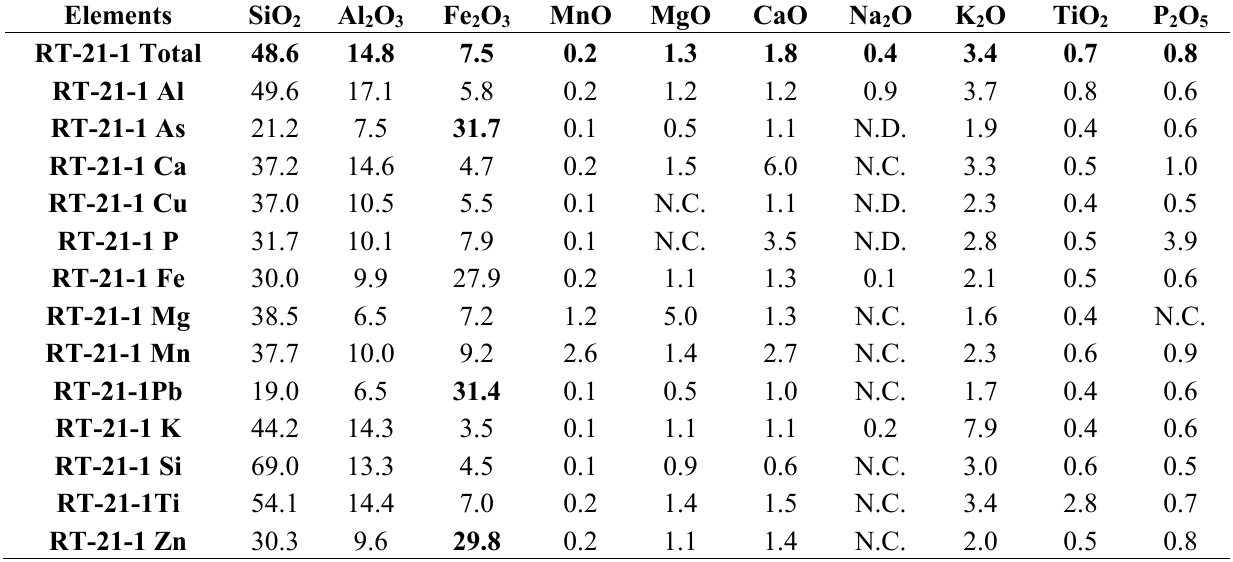
Table 11. Chemical analysis of major elements (%) by PIXE of the total sample and accumulations indicated in elemental maps.